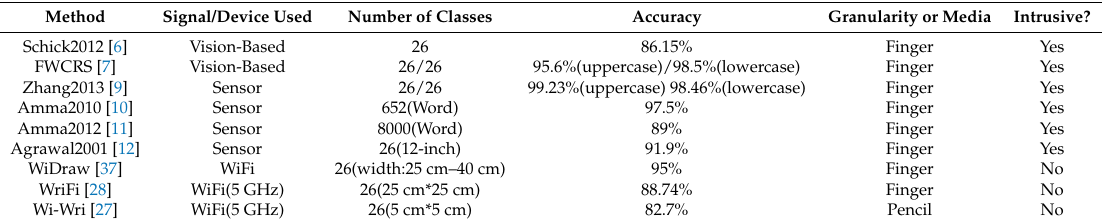
Table 2. Comparison of handwritten motion recognition methods using WiFi. FWCRS = finger writing character recognition